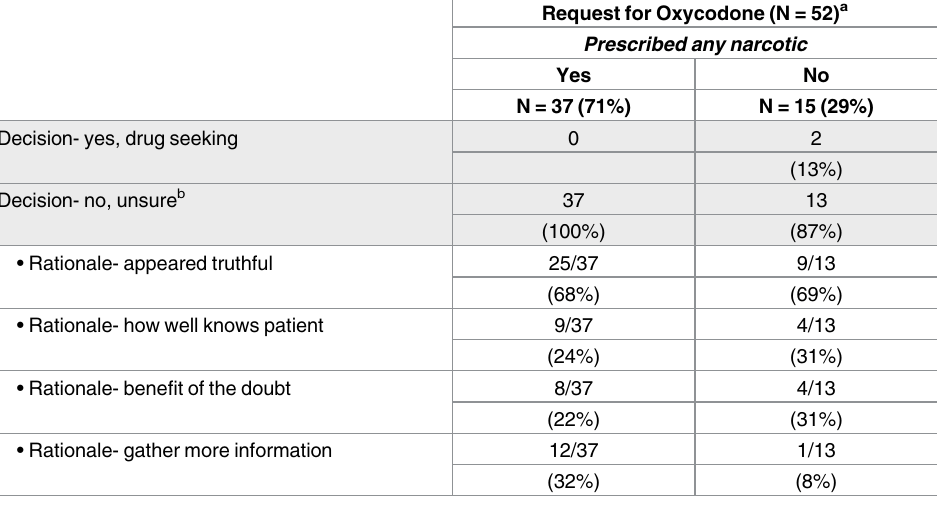
Table 4. Judgments about drug seeking by medication requested among physicians who mentioned drug seeking in the qualitative interview for sciatica patient (N = 52). Request for Oxycodone (N = 52)